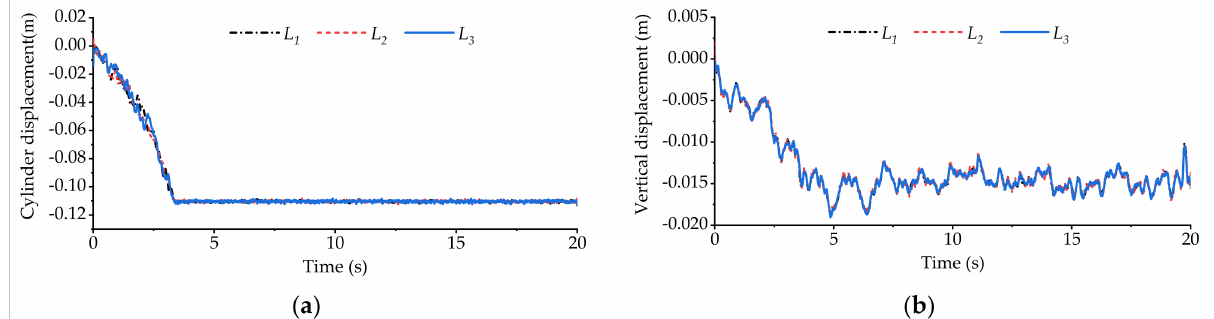
Figure 16. Vertical displacement of vehicle body in longitudinal slope experiment.